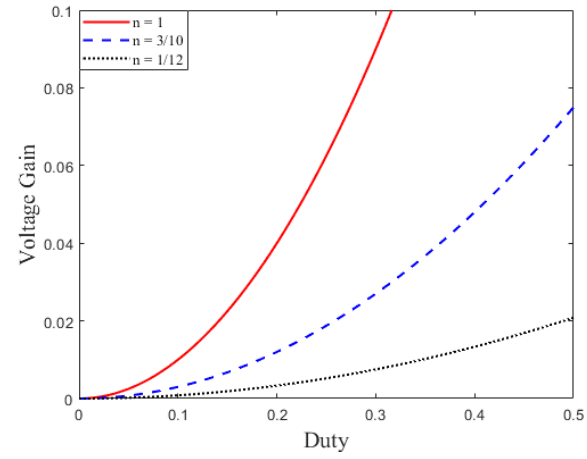
Figure 11. Ideal voltage gain of the proposed topology.